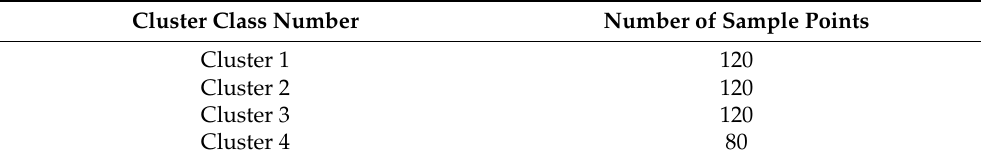
Table 2. Statistics of sample points in the cluster.